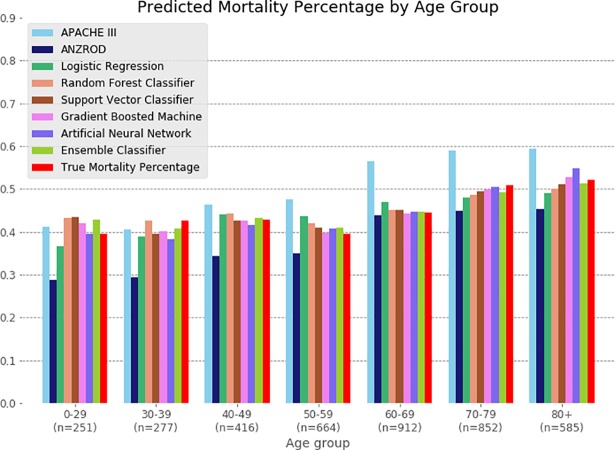
Sensitivity analysis comparing model performance across age groups.True mortality for each group is indicated in red. ANZROD, Australian and New Zealand Risk of Death.